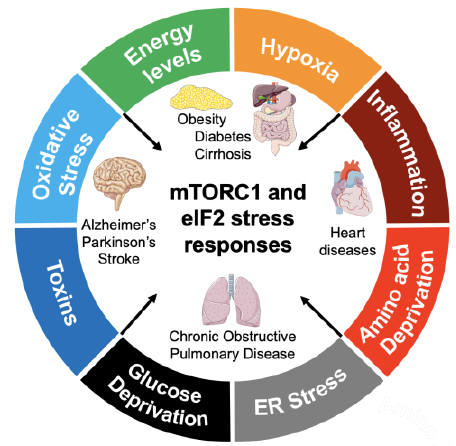
Figure 1. Pathological regulation of mTORC1 and eIF2 stress response in non-communicable diseases. Many cellular stress conditions in di ff erent tissues and organs involve activation of the ISR with eIF2 α phosphorylation and dysregulation of the mTORC1 signaling pathway. Particularly affected are the brain, liver, pancreas, lungs, and heart, which contribute to chronic diseases such as Alzheimer’s, Parkinson’s, stroke, diabetes mellitus, liver cirrhosis, chronic obstructive pulmonary disease, and heart diseases.